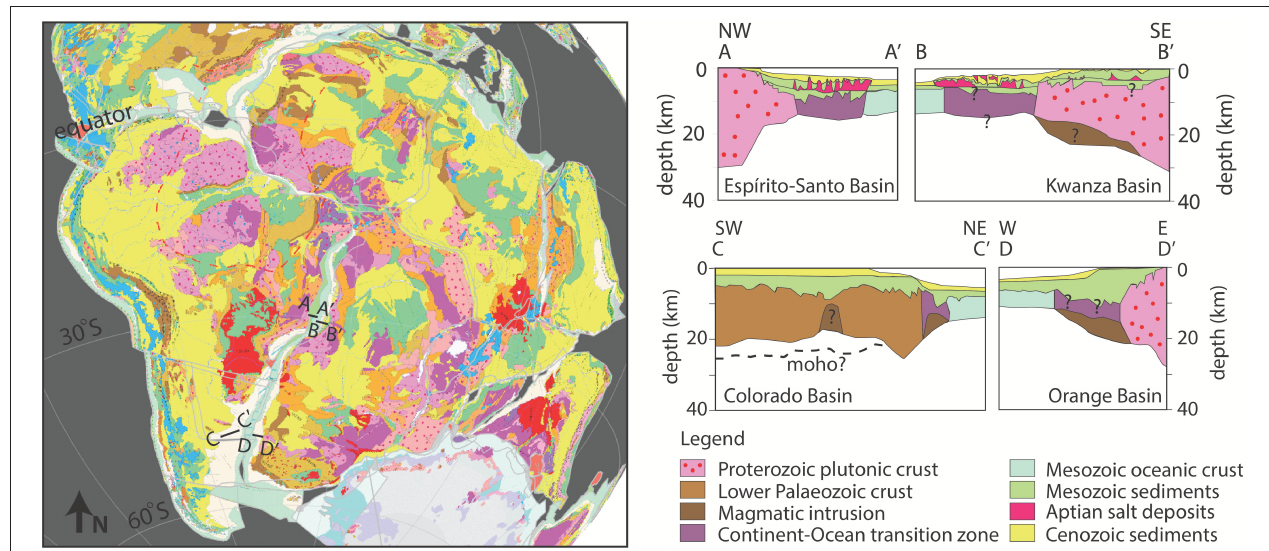
FIGURE 1 | Reconstructed projection of the geological maps of South America and Africa before break-up. Reconstruction has been done using the rotation poles and continental polygons of Seton et al. (2012). The geological map has been extracted from the Geological Map of the World by Bouysse (2014). The cross-sections A-A’, B-B’, C-C’, and D-D’, have been simplified after Blaich et al. (2011) and projected on the reconstruction. The reconstructed geology shows that the continents consist of an amalgamation of different crustal features. This has been adopted for the crustal cross-sections resulting in similar crustal features for the continental part of the Espírit-Santo Basin and Kwanza Basin margins (Proterozoic plutonic crust) and different crustal features for the continental part of Colorado Basin margin (Proterozoic sedimentary crust) and the Orange Basin